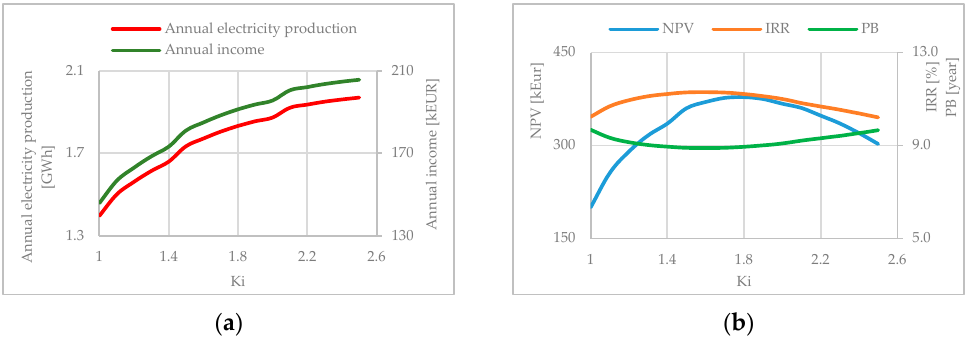
Figure 4. ( a ) Annual electricity production and income—Bukoviˇcko SHPP; ( b ) NPV, IRR, and PB—Bukoviˇcko